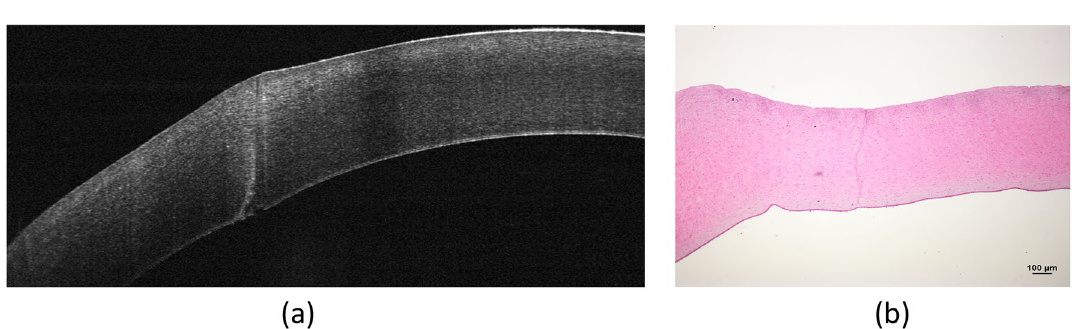
Figure 6. ASOCT and a representative histological section showing laser trephination with 30% energy. Both ASOCT images ( a ) and histological section ( b ) showed that the trephination was not cut